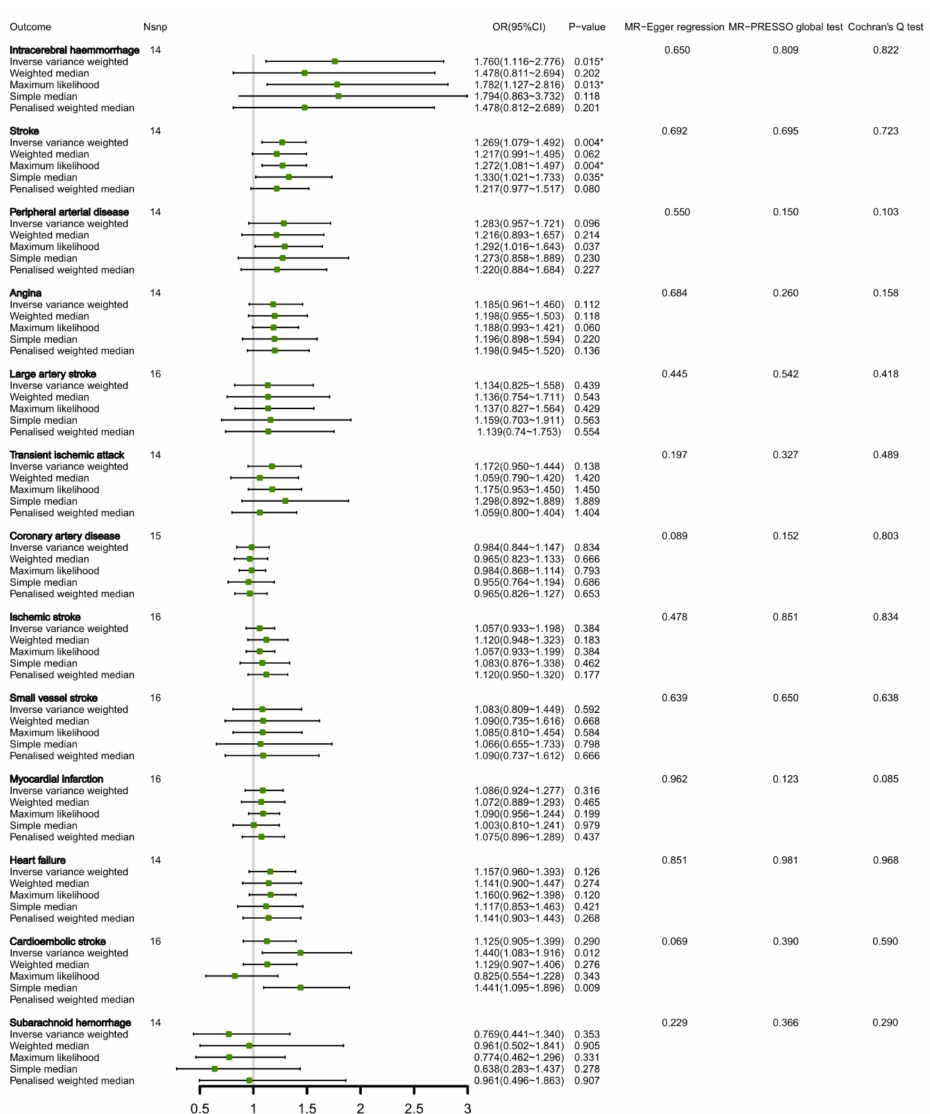
Figure 2. MR estimates of the associations between circulating valine levels and CVDs. * Indicates p < 0.05. Nsnp, number of